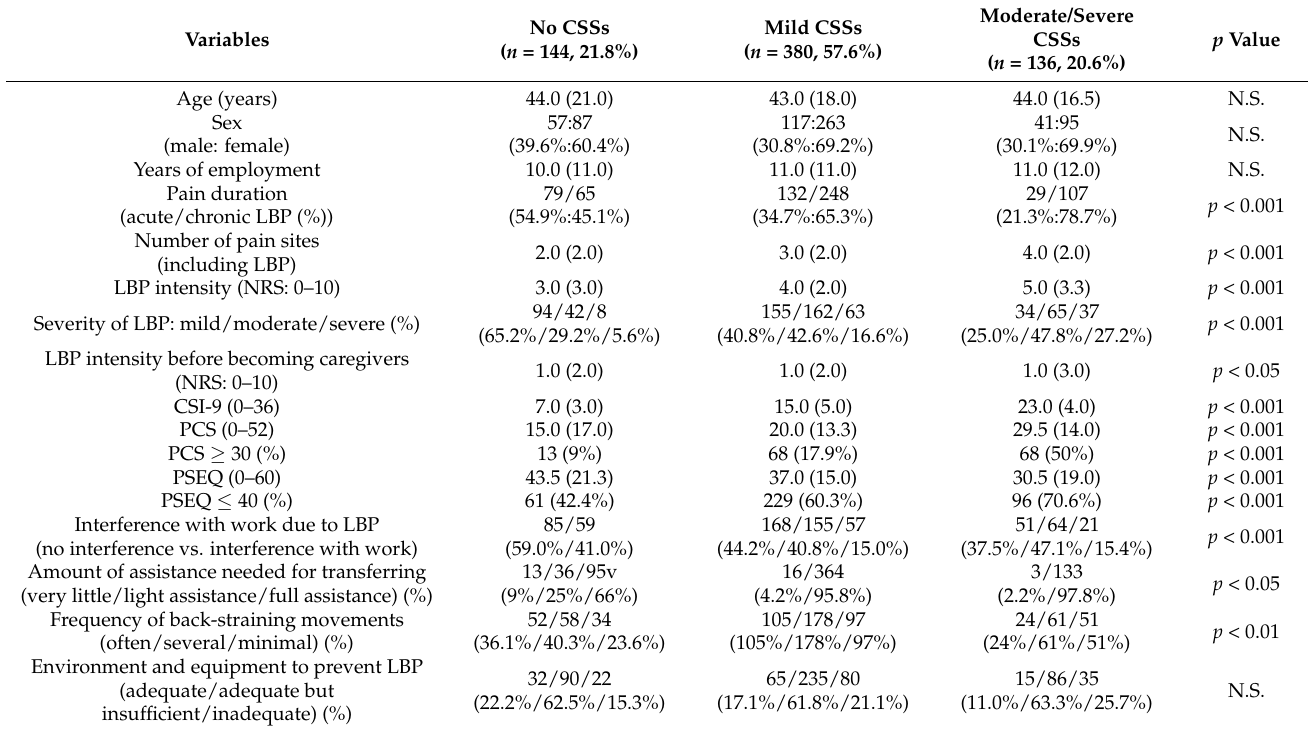
Table 1. Characteristics according to the CSS severity group.